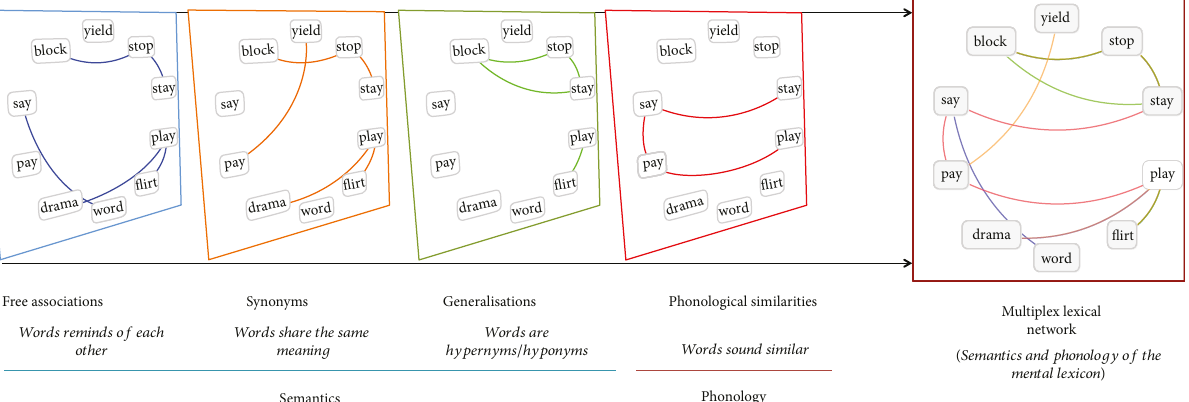
Figure 1: Network visualisation of a portion of the adopted multiplex lexical network. The whole multiplex representation contains 8546 words. Semantic layers are clustered together (free associations, synonyms, and generalisation) and represent multiple aspects of semantic memory. Phonological information is represented as a network of phonological similarities, where words di ff ering by one phoneme were linked together. The resulting multiplex lexical network is an edge-coloured graph where links of di ff erent types coexist (see right